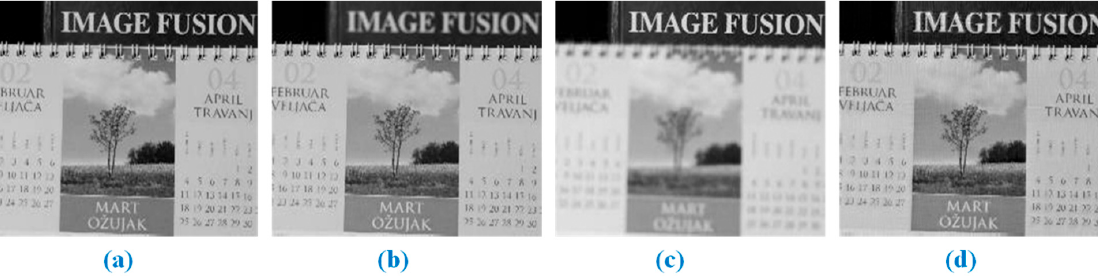
Figure 6. (Calendar): ( a ) original image; ( b , c ) multi-focus input images; and ( d ) proposed fusion.